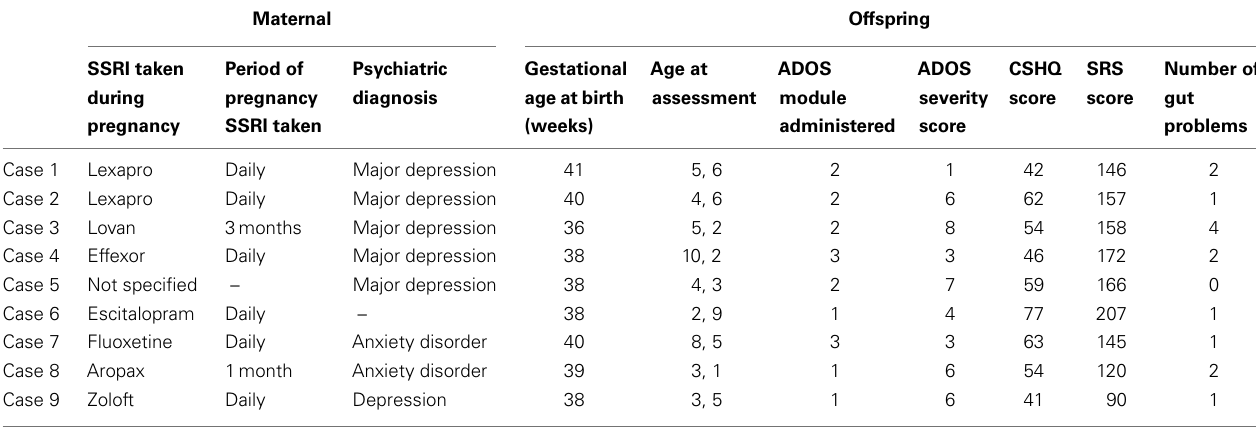
Table 1 | Study 1: maternal and offspring characteristics of the SSRI case group.